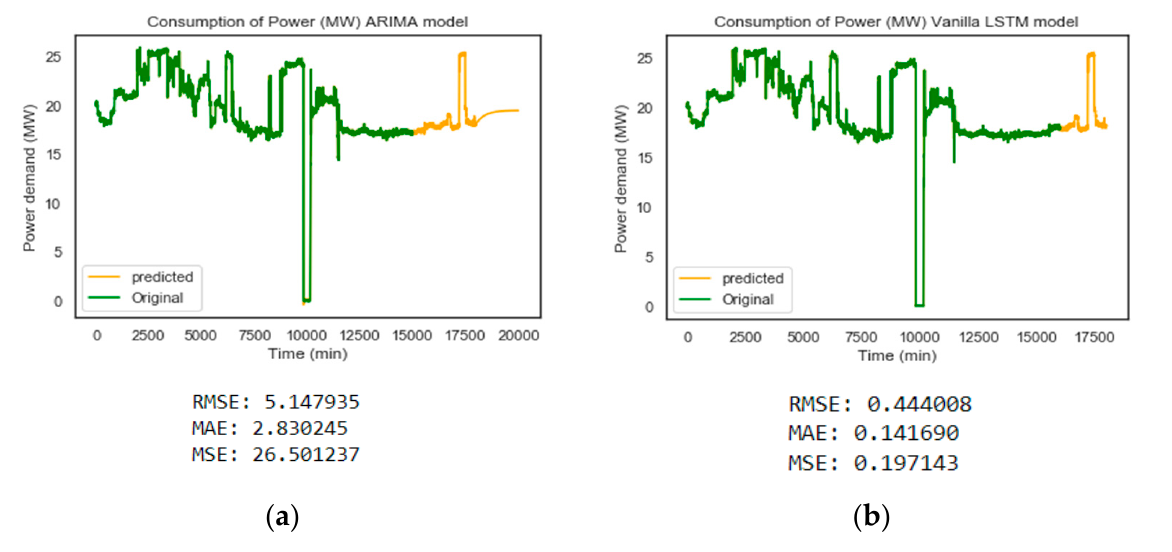
Figure 22. Power demand forecasting performances based on ARIMA model ( a ). Power Demand forecasting performances based on LSTM Vanilla ( b ).